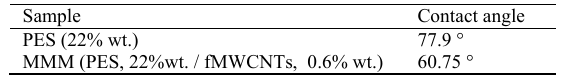
Fig. 4. Cross sectional FESEM micrographs of the neat membrane containing 22 wt. % PES (a and b) and the mixed matrix Fig. 4. Cross-sectional FESEM micrographs of neat membrane containing 22 wt. % PES (a and membrane containing 22 wt. % PES and 0.6 wt.% fMWCNTs (c and d) b) and The mixed matrix membrane containing 22 wt. % PES and 0.6 wt.% fMWCNTs (c and Fig. 4. Cross-sectional FESEM micrographs of neat membrane containing 22 wt. % PES (a and Table 1. Water contact angels of neat membrane containing 22 wt. % PES and the MMM containing 22 wt. % PES and 0.6 wt.% fMWCNTs. d). b) and The mixed matrix membrane containing 22 wt. % PES and 0.6 wt.% fMWCNTs (c and Table 1. Water contact angels of neat membrane containing 22 wt. % PES and the MMM containing 22 wt. % PES and 0.6 wt.% d). Sample